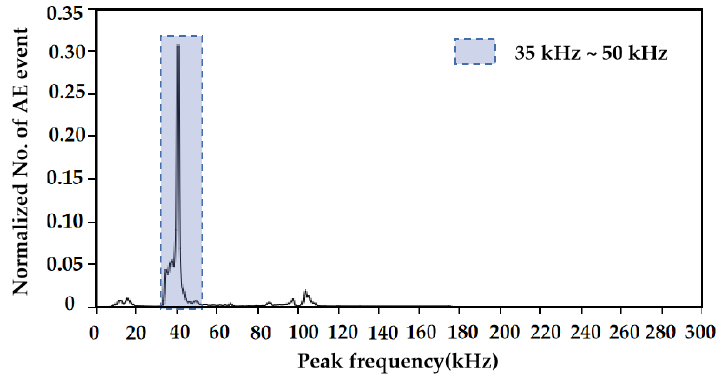
Figure 9. Peak frequency distribution of ordinary concrete.